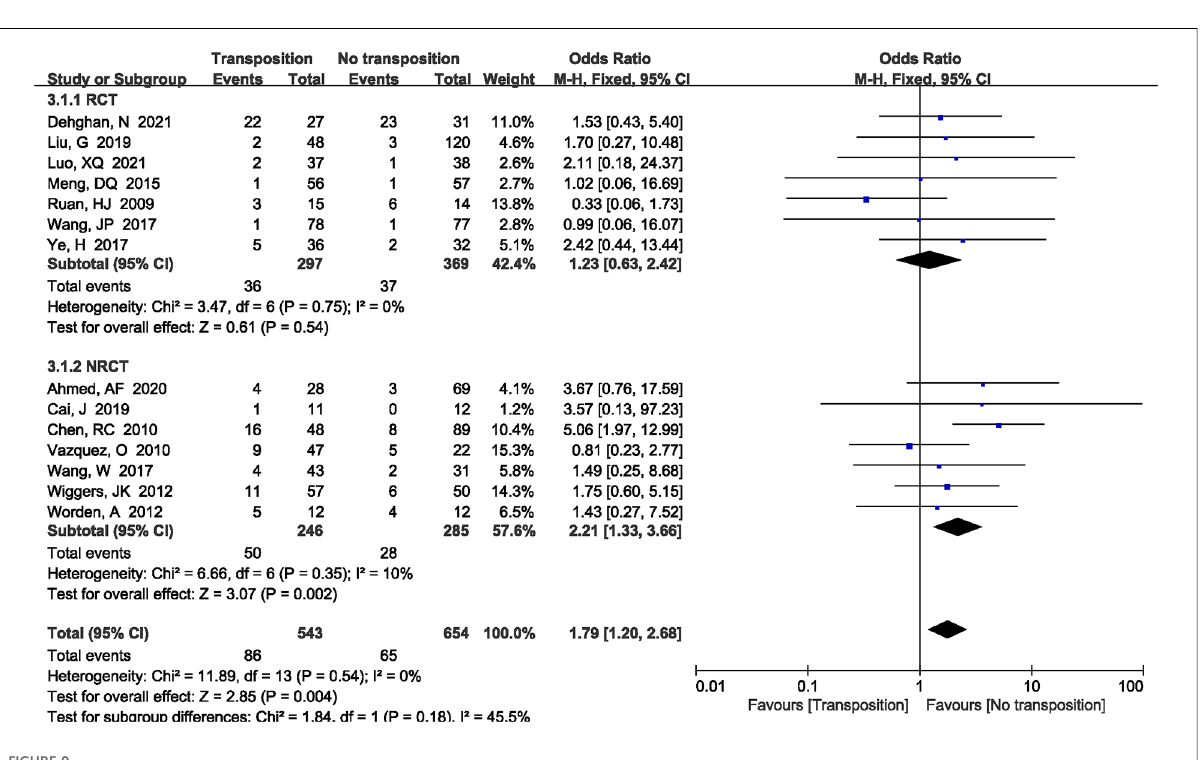
FIGURE 9 A forest plot showing the ulnar